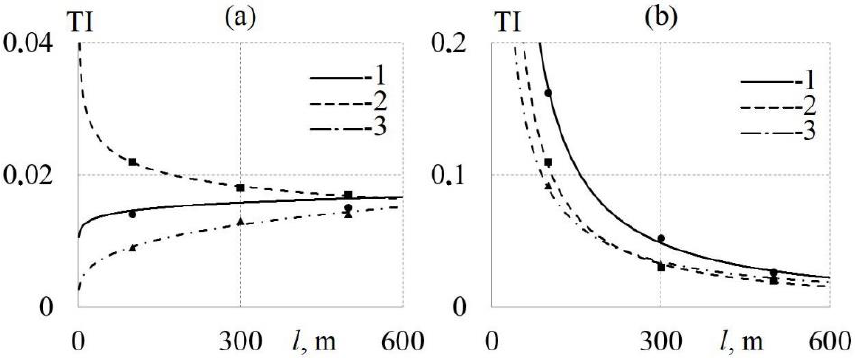
Figure 6. Dependences of turbulence intensity TI along the length of (1) round, (2) square, and (3) triangular pipes for average air velocity w = 20 m/s and at initial values TI: ( а ) TI = 0.02; ( b ) TI = 0.12.